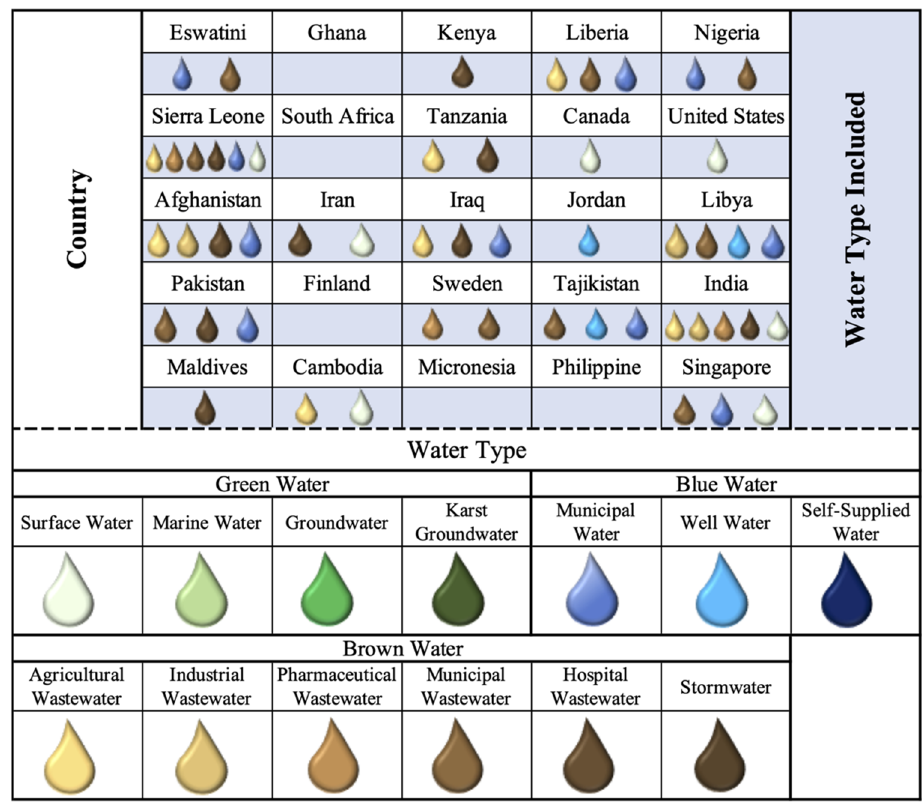
Figure 8. Breakdown of water categories and types included in the NAP case studies.